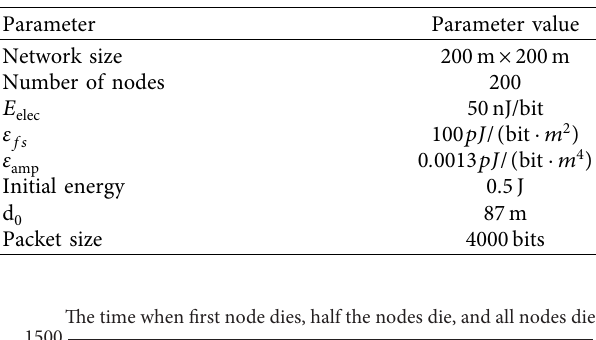
Table 2: Simulation experiment parameters.